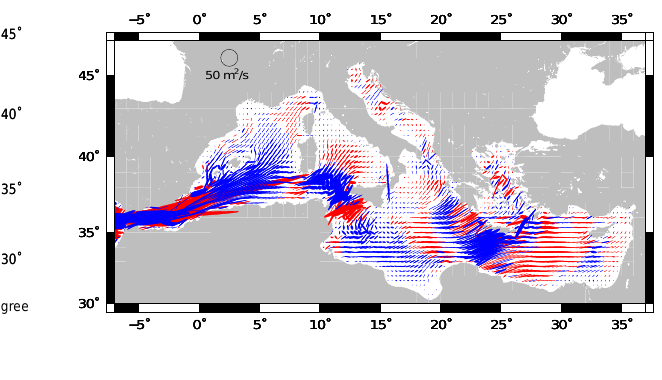
Fig. 13. Transport ellipses of M2 constituent. Red = clockwise, blue = anticlockwise